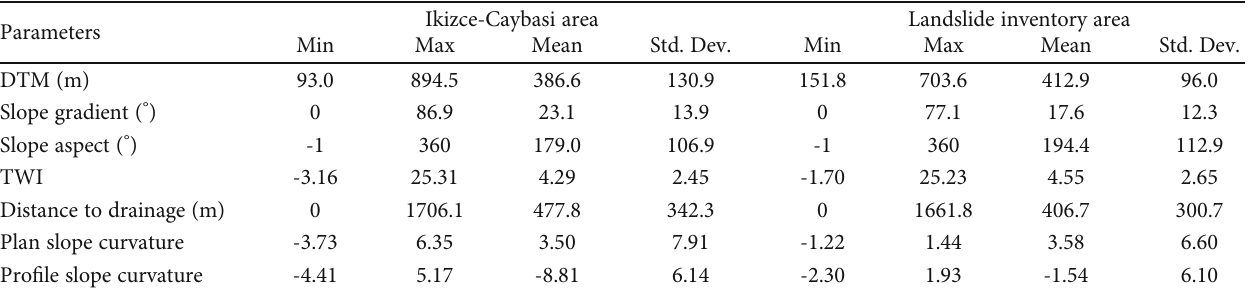
Figure 10: The DTM and the landslide inventory of Ikizce-Caybasi area. Table 1: Descriptive statistics of the topographical data obtained for subarea and the area with landslide.